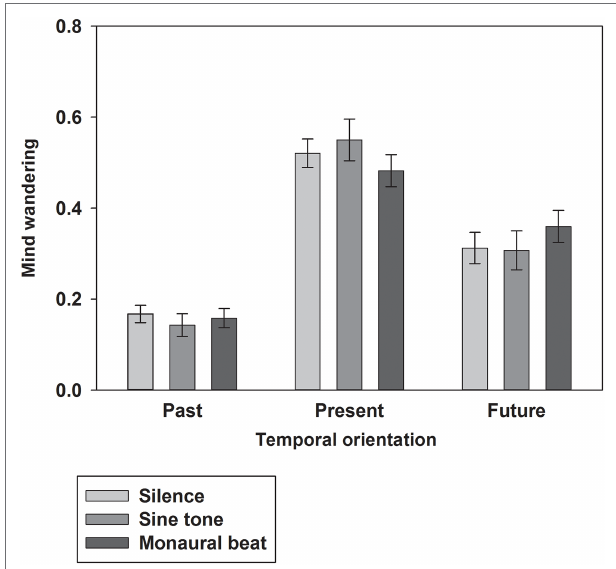
FIGURE 3 | Temporal orientation of mind wandering. The average ratios of past-, present-, and future-oriented MW shown across subjects for the three stimulation conditions. Mean and SEM are depicted.